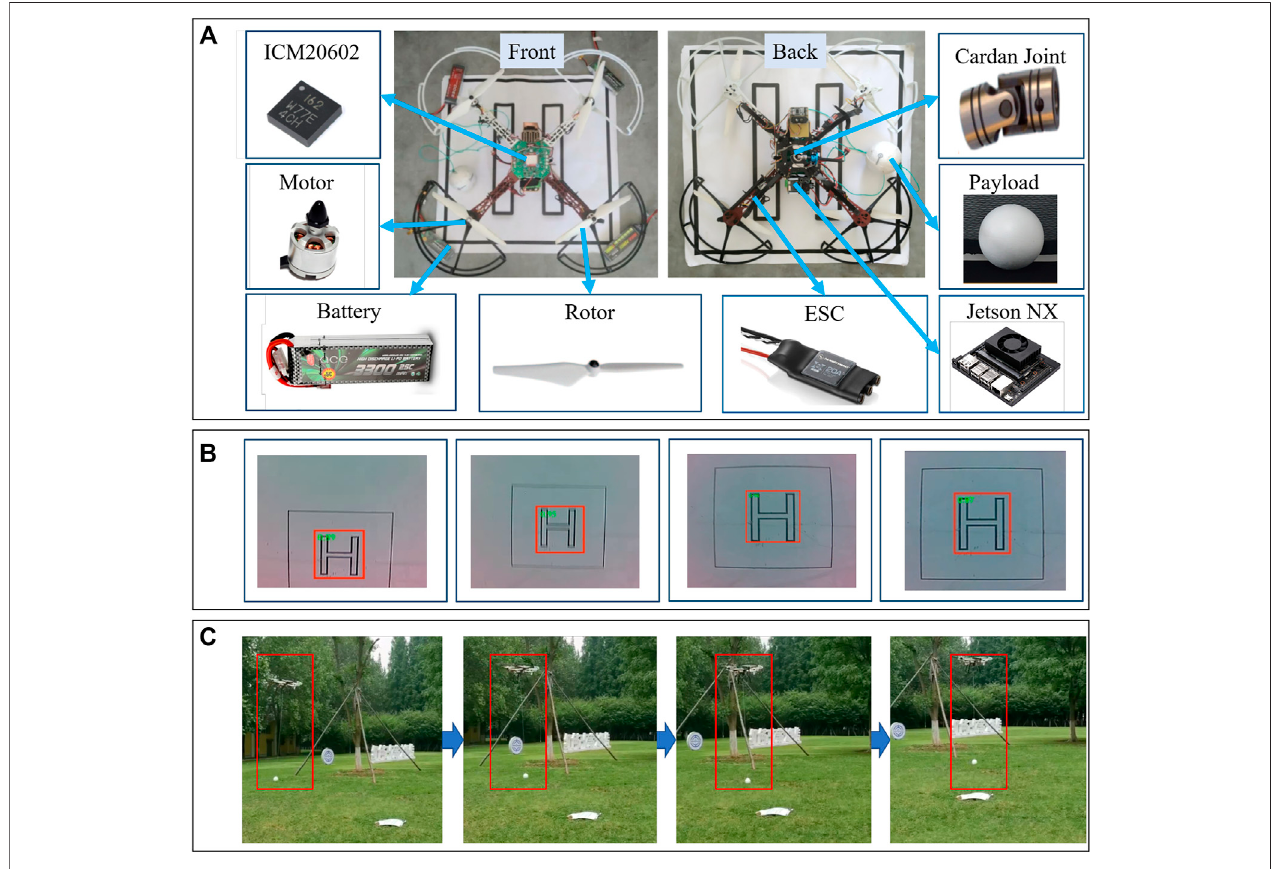
FIGURE 3 | Experimental platform of QCSP object detection and position control fl ight test.